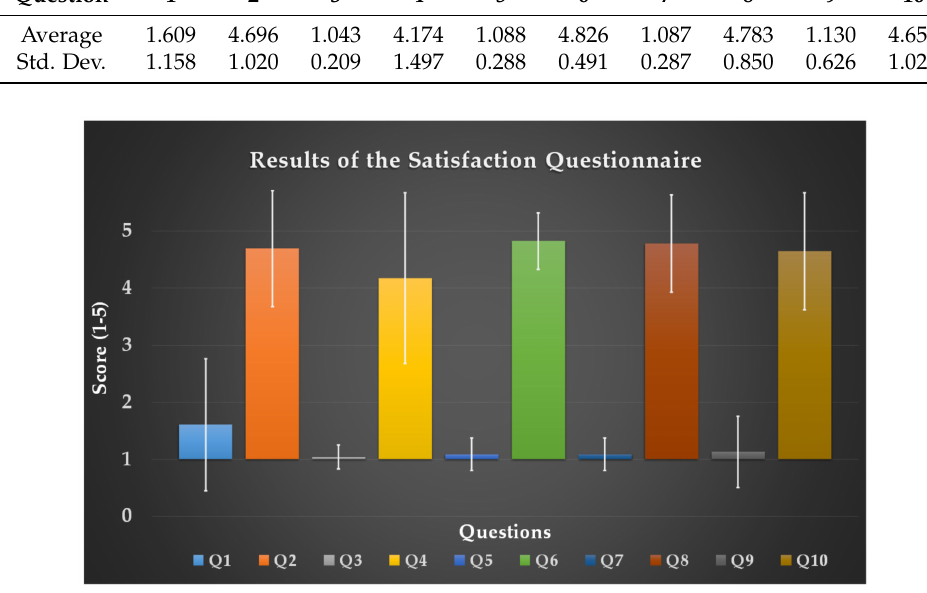
Figure 11. Results of the SUS